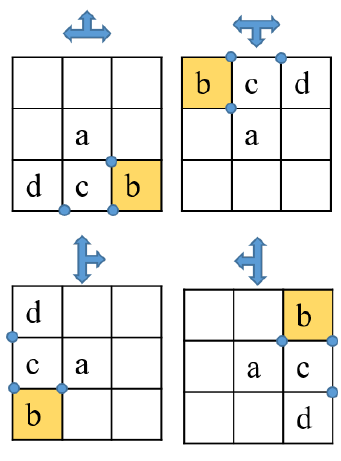
Figure 9. Unique shape matrix with respect to hTetro orientation.